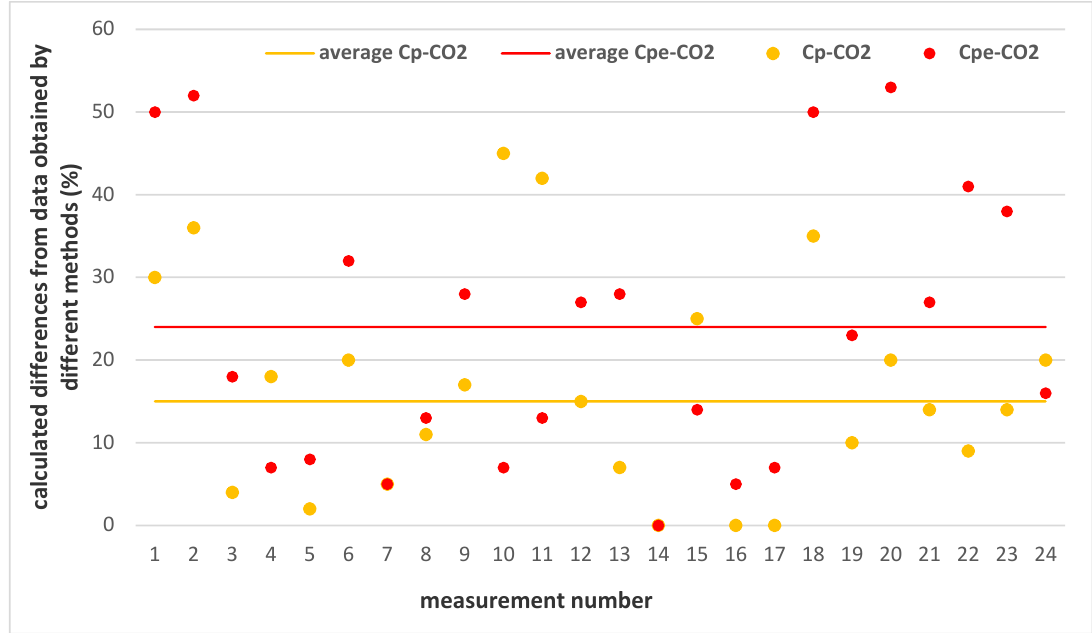
Figure 13. Calculated differences and percentage differences in air change rate determined by different methods. Table 4. Calculated differences and percentage differences in air exchange rate determined by different methods for lower wind